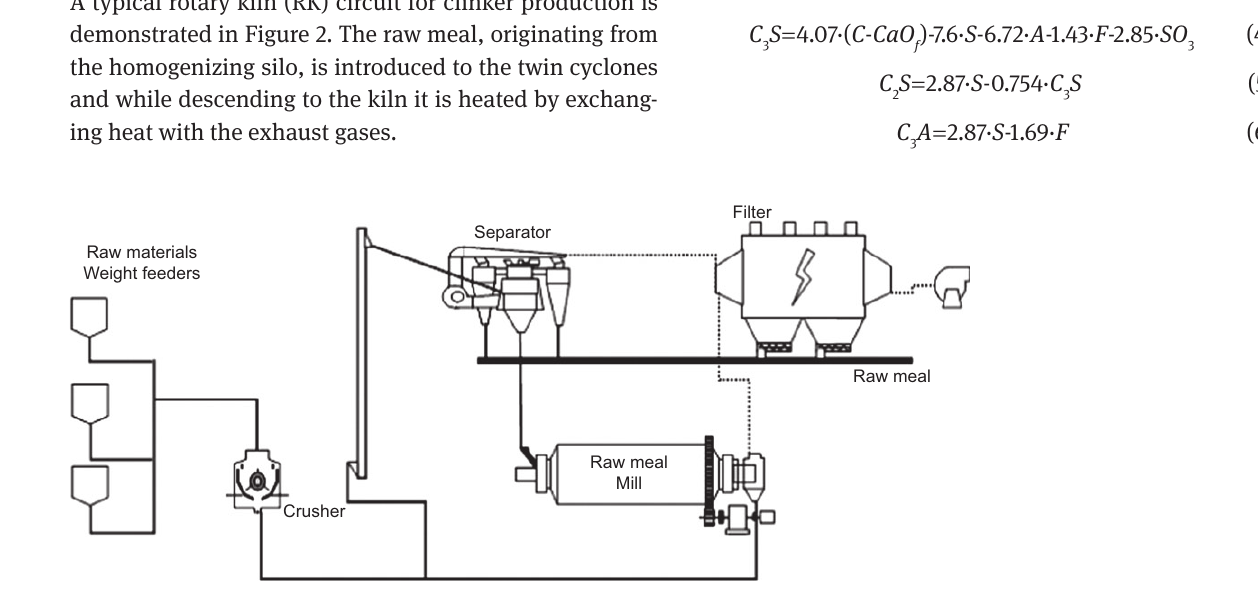
Figure 1 Flow chart of raw meal